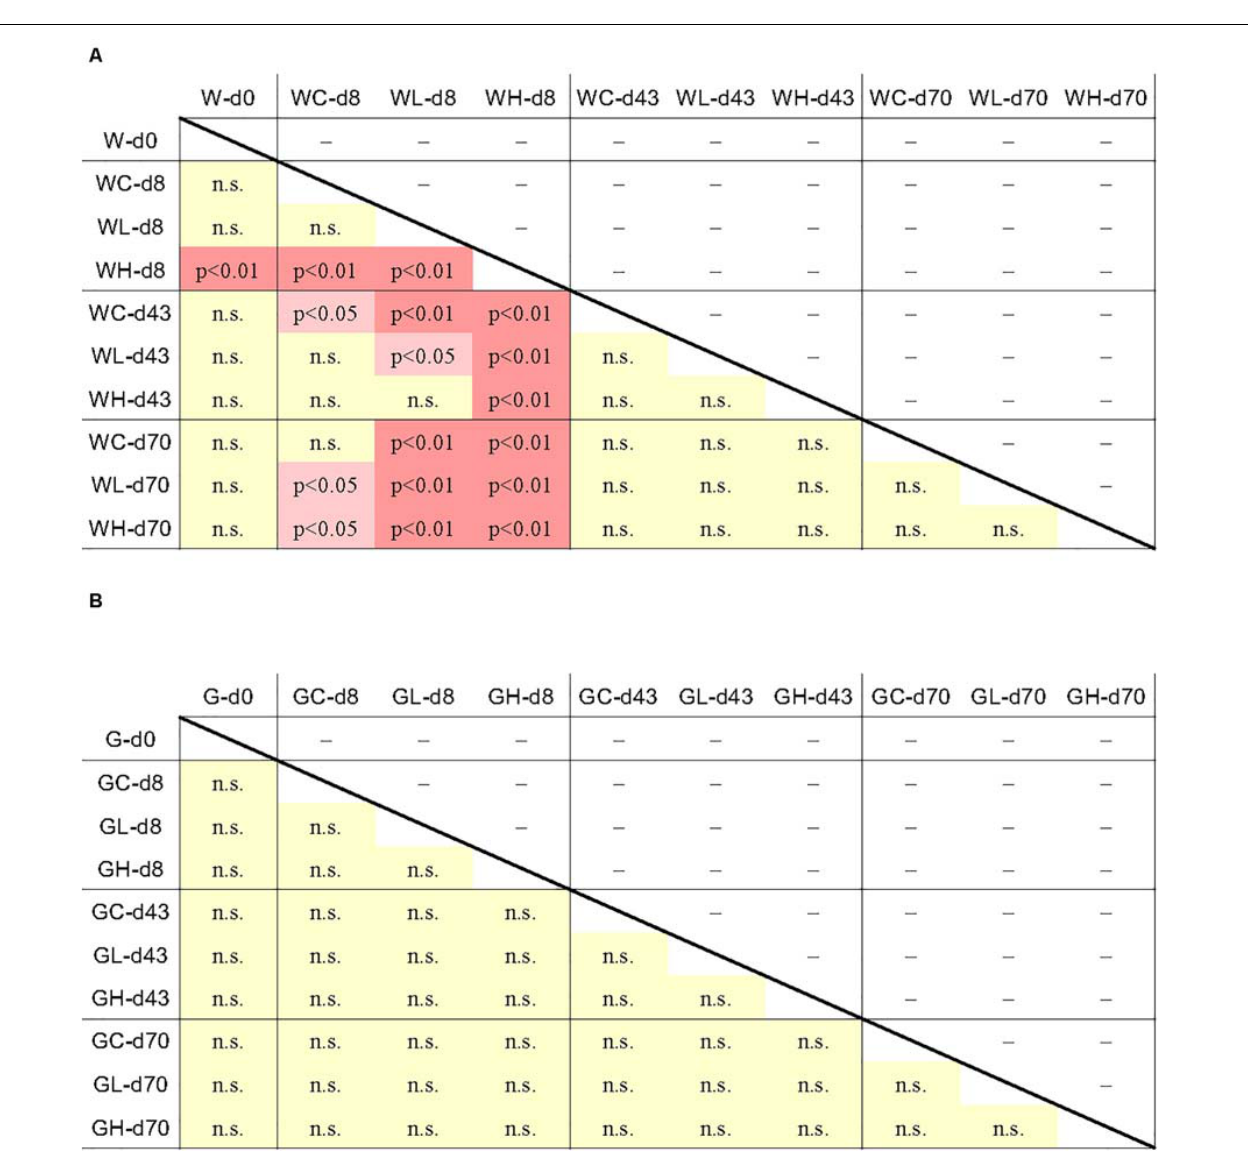
FIGURE 4 | Results of the Tukey-Kramer multiple comparison test for all pairwise comparisons of tet gene abundance (six tet genes total) between the average of each sample group. Difference of the tet gene abundance between the sample groups was significant when p < 0.05 or p < 0.01. (A) rearing water; (B) fish intestine. n.s., not